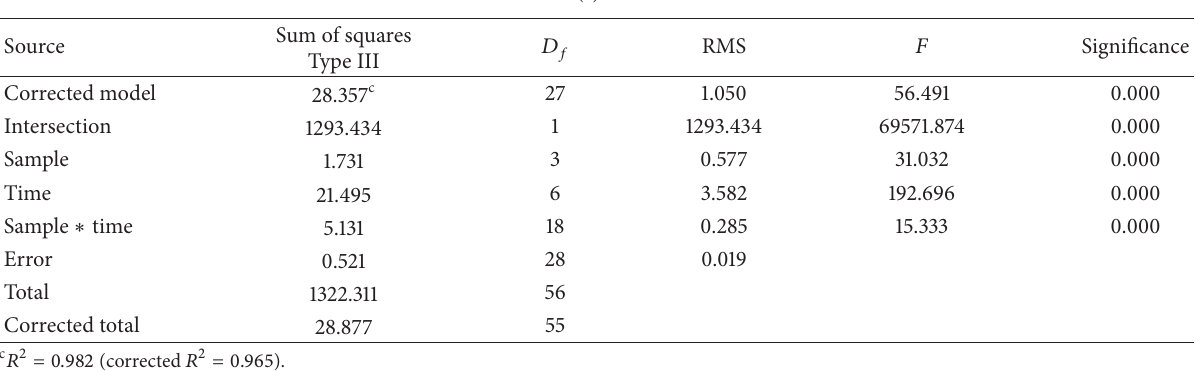
a 𝑘 = 𝑒 20.30 𝑒 −7959.85(1/𝑇) . b